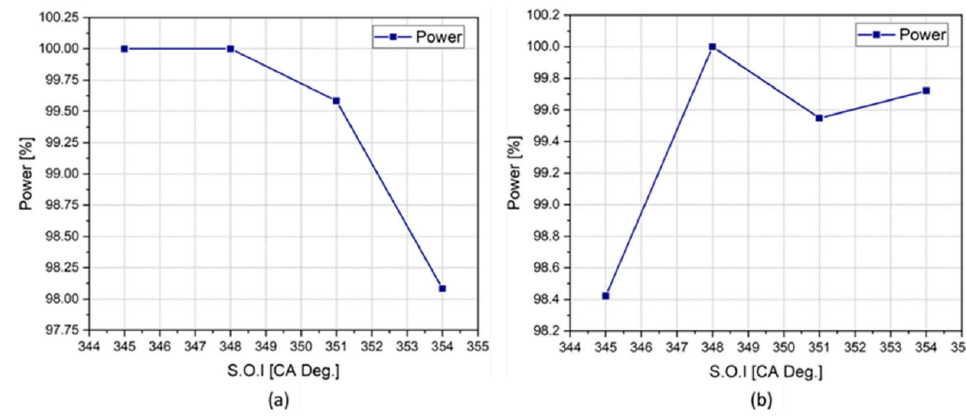
Figure 25. The engine powers according to the change of the pilot S.O.I angle in the diesel mode ( a ) and dual-fuel mode ( b